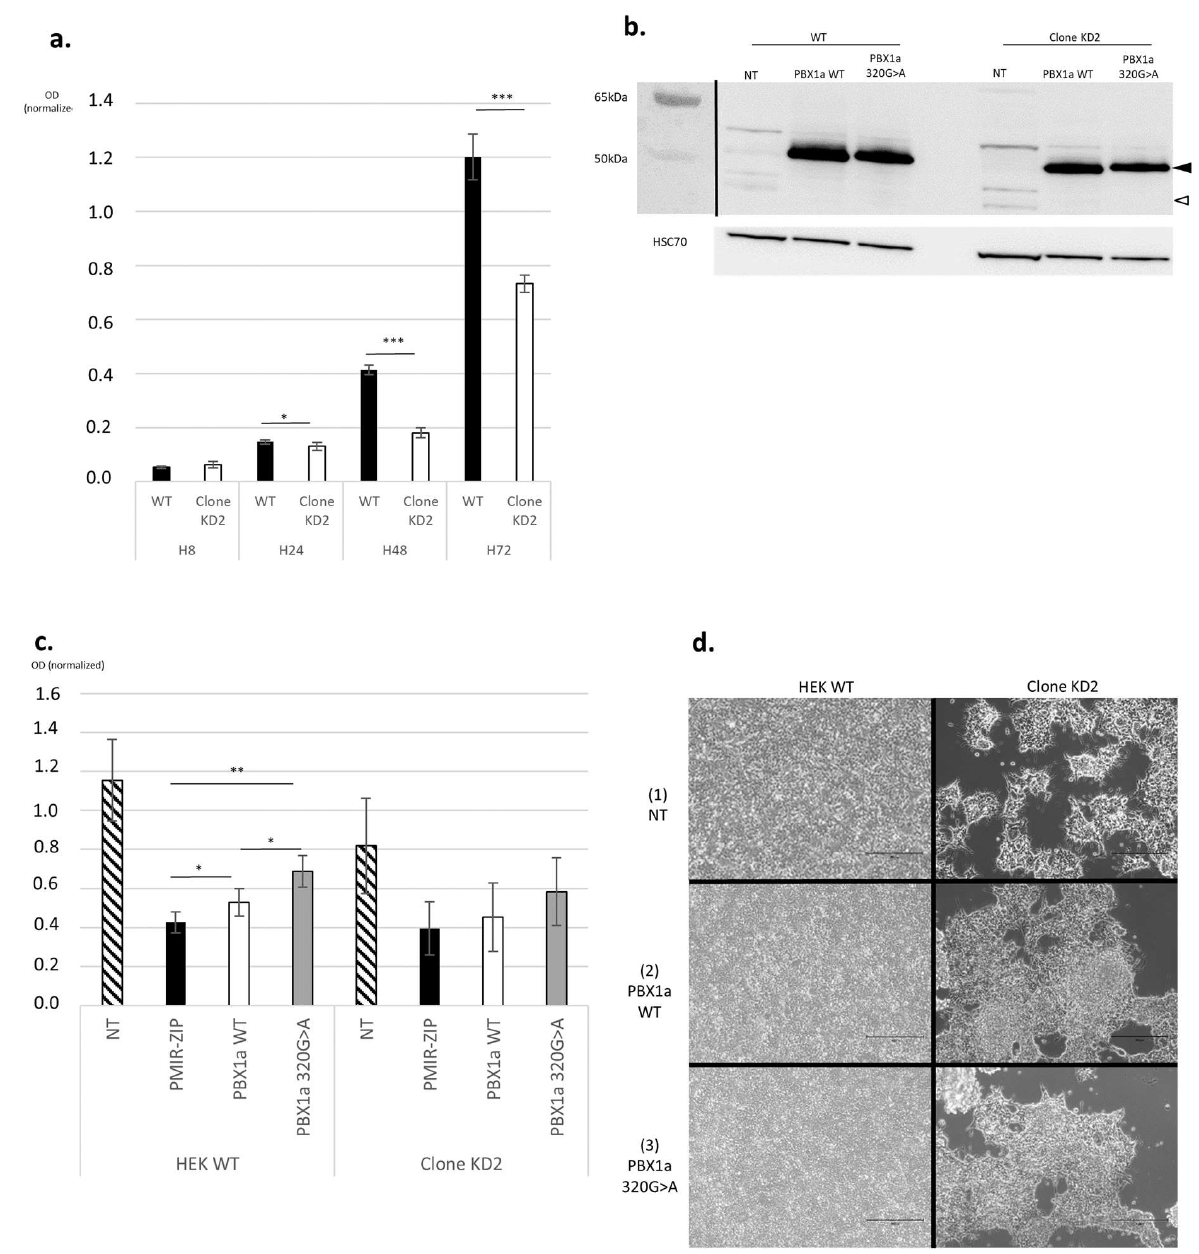
Figure 4. PBX1 partial LoF impairs cell proliferation, not fully rescued by PBX1a transfection. ( a ) PBX1 LoF impairs cell proliferation (Methylen blue test). OD: optical density. H: hours. Bars repre- sent standard deviations (SD). ( b ) WB assessing PBX1a overexpression (black arrowhead) in trans- fected HEK WT cells (HEK WT) and KD2 clones. White arrowhead: PBX1b. ( c ) Transfection with